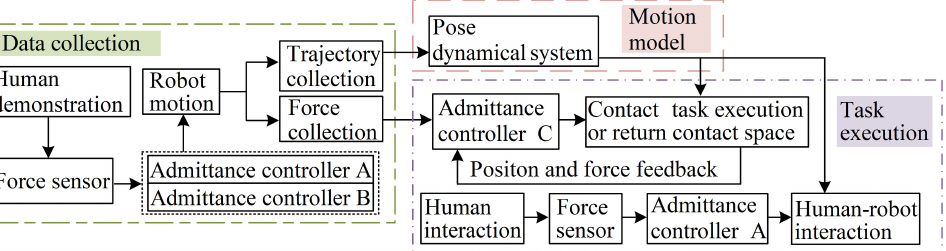
Figure 1. The framework for the robot learning the contact task skills under human interaction. The data of the human executing the contact task are collected by kinesthetic demonstration. The demonstration trajectory is modeled by a time-invariant pose DS. Considering the various demands for human–robot interaction, the robot reproducing human skills, and resuming working, the different motion controllers were designed based on the pose DS and admittance